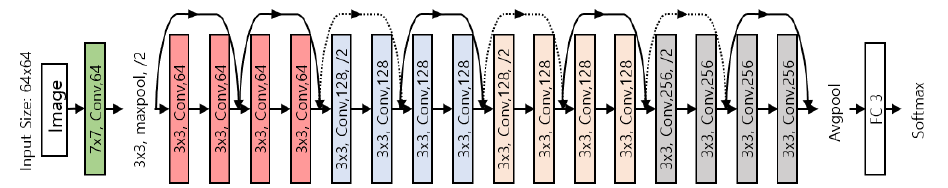
Figure 5. CNN (convolutional neural network) architecture of modified ResNet-18. We applied weighted sum